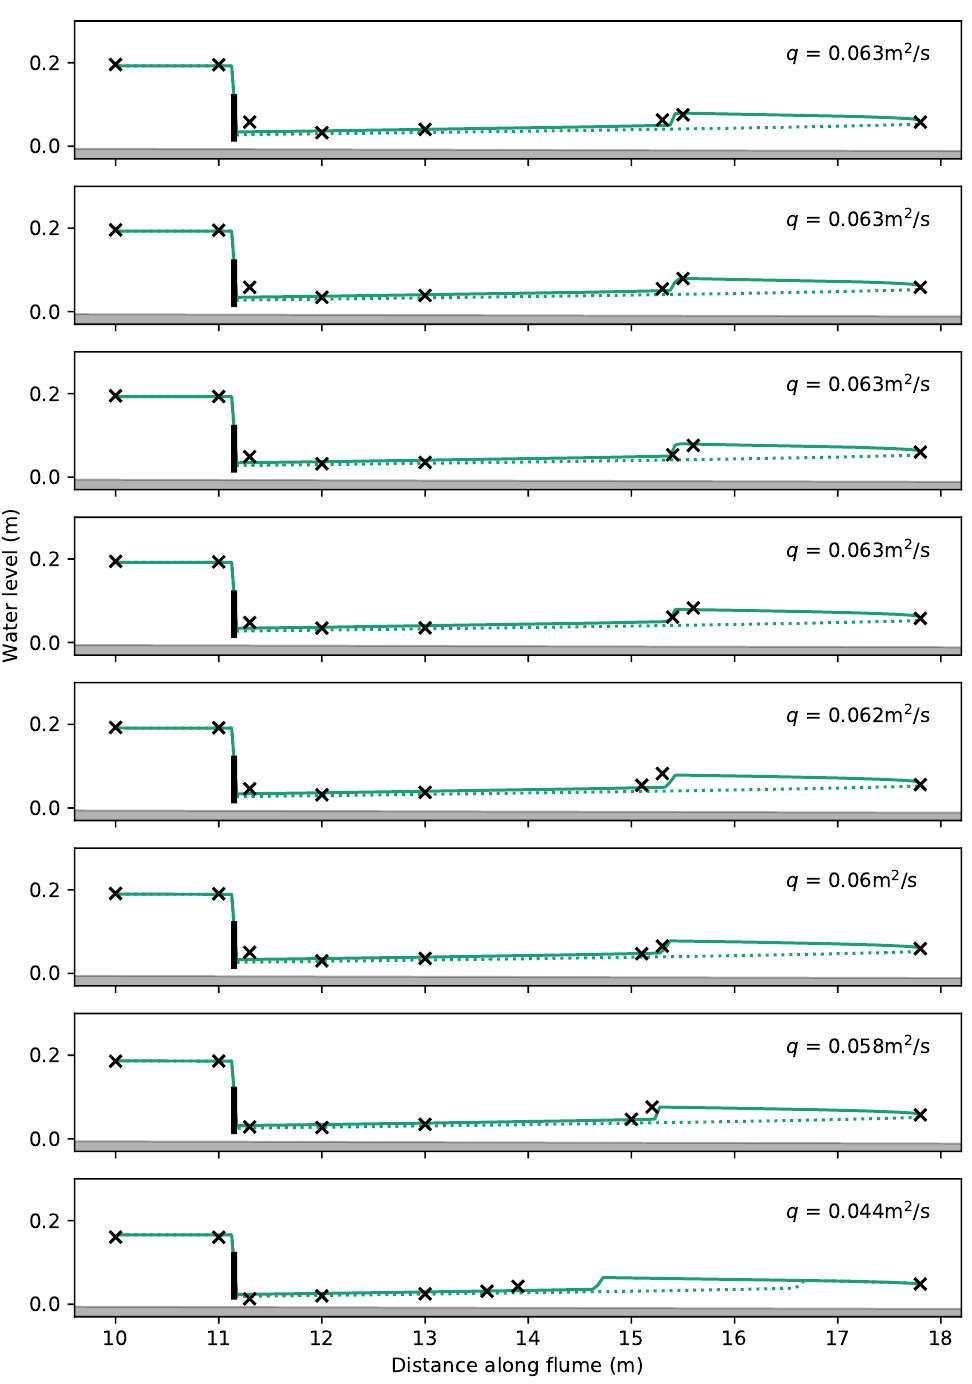
Figure A6. Results for configuration